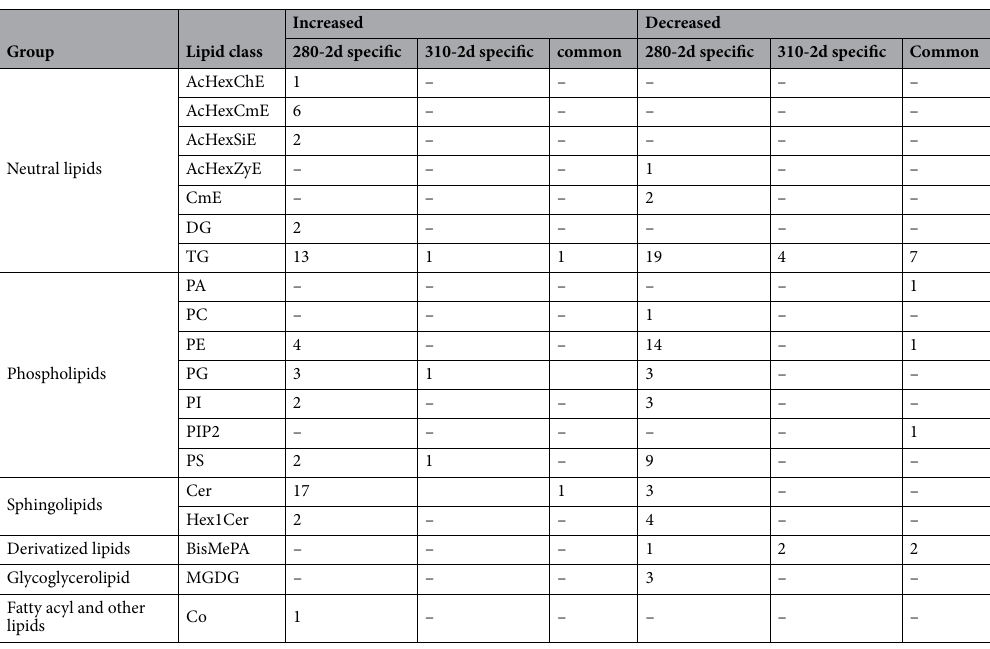
Table 1. Classification of identified lipids whose amounts were significantly changed by UV-LED irradiation. Welch’s t -test was performed to determine significant differences ( P < 0.05) between the control and UV-LED irradiated Arabidopsis. AcHexChE AcylGlcCholesterol ester, AcHexCmE AcylGlcCampesterol ester, AcHexSiE AcylGlcSitosterol ester, AcHexZyE AcylGlcZymosterol ester, CmE campesterol ester, DG diglyceride, TG triglyceride, PA phosphatidic acid, PC phosphatidylcholine, PE phosphatidylethanolamine, PG phosphatidylglycerol, PI phosphatidylinositol, PIP2 phosphatidylinositol, PS phosphatidylserine, Cer Ceramides, Hex1Cer simple Glc series, BisMePA bis-methyl phosphatidic acid, MGDG monogalactosyldiacylglycerol, Co